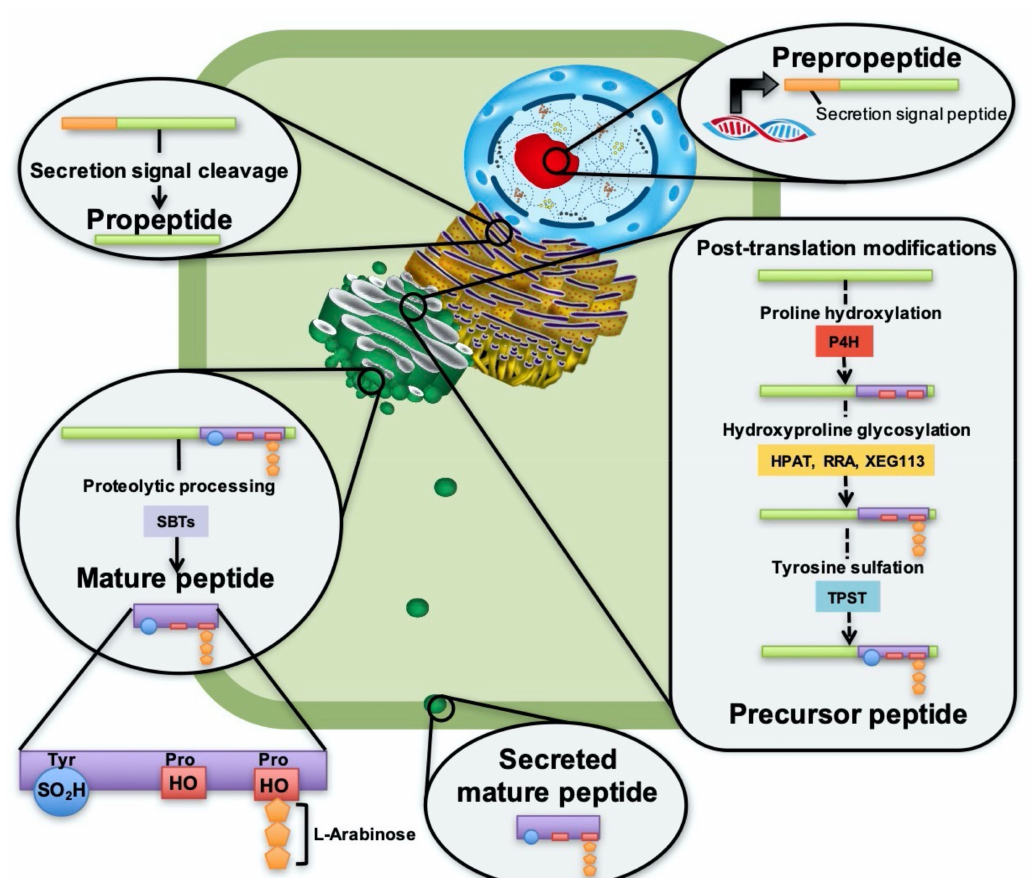
Figure 1. Proposed PSY synthesis pathway and suggested enzymes involved in PSY processing. PSY genes are expressed in the nucleus as prepropeptides carrying a secretion signal peptide. The secretion signal is cleaved upon arrival in the endoplasmic reticulum (ER), revealing the propeptide. The propeptide is received in the cis-Golgi where it undergoes post-translational modifications to become a precursor peptide. Prolyl-4-hydroxylases (P4H) catalyze hydroxylation of proline. Hydroxyproline O-Arabinosyltransferases (HPAT) catalyze the attachment of a L-Arabinose unit to one of the two hydroxyl groups. Reduced Residual Arabinose (RRA) and Xyloglucanase113 (XEG113) are proposed to attach the second and third arabinose unit, respectively. Tyrosylprotein sulfotransferase (TPST) catalyzes the sulfation of the tyrosine residue. Before reaching the Trans-Golgi network, the precursor peptide is proteolytically processed to release the mature peptide. Subtilases (SBTs) and in particular SBT3.8 and SBT6.1 are suggested to be involved in PSY processing. The mature peptide is transported from the trans-Golgi to the cell membrane in vesicles, where it fuses with the membrane to secrete the mature peptide to the apoplast.